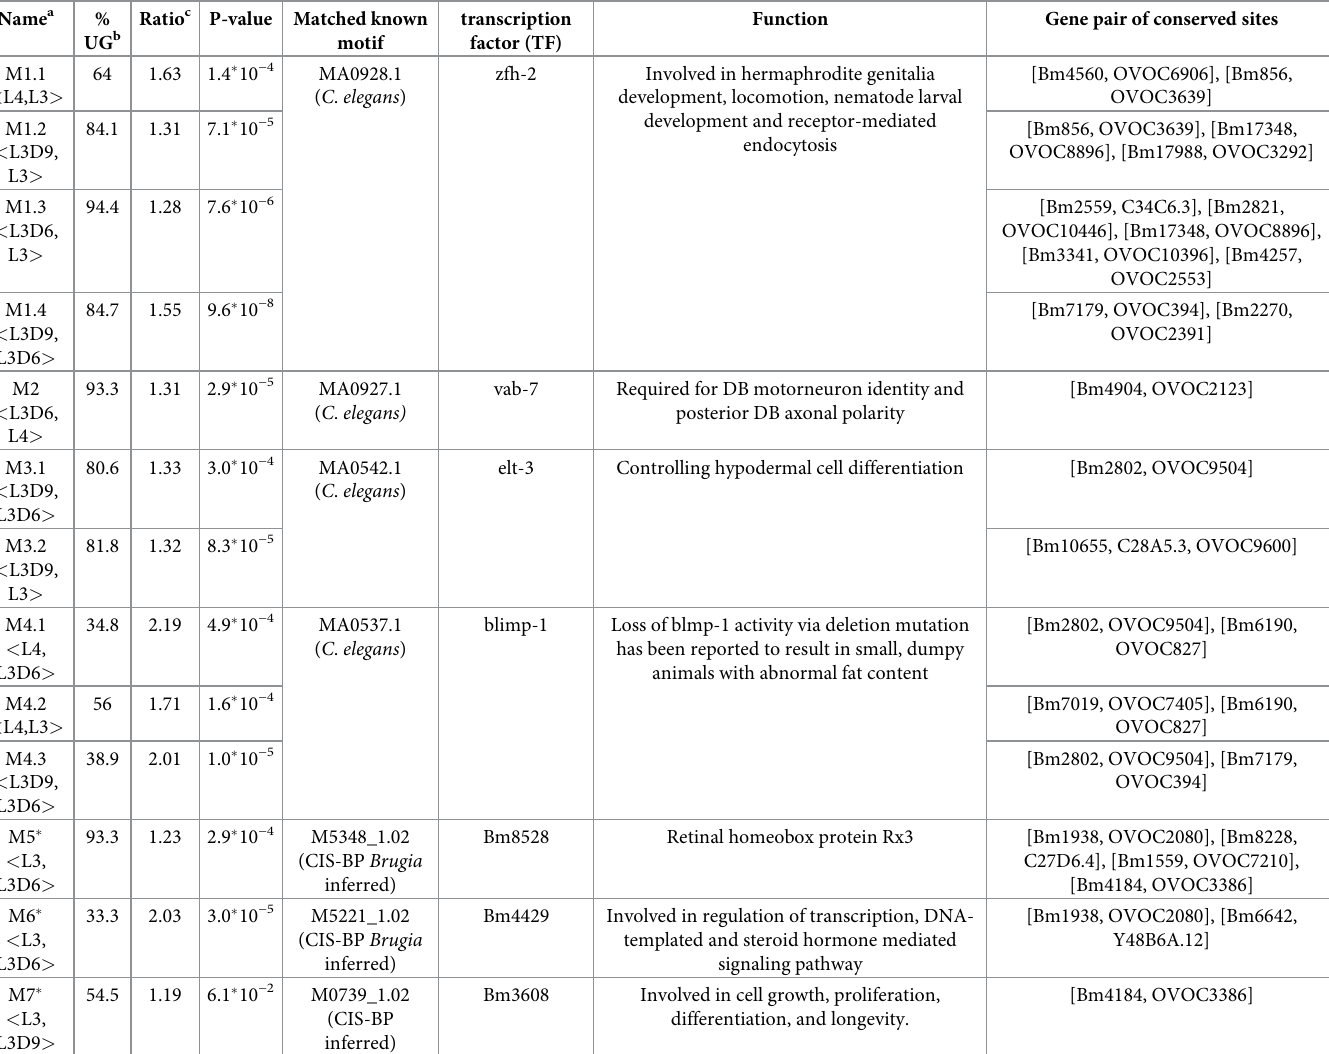
Table 2. List of enriched promoter motifs over the L3 to L4 molt.